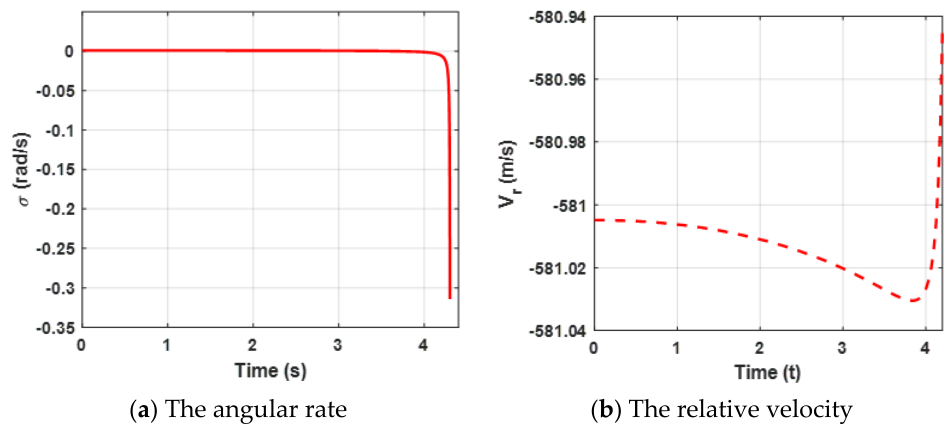
Figure 2. Engagement scenario for the proposed guidance strategy.